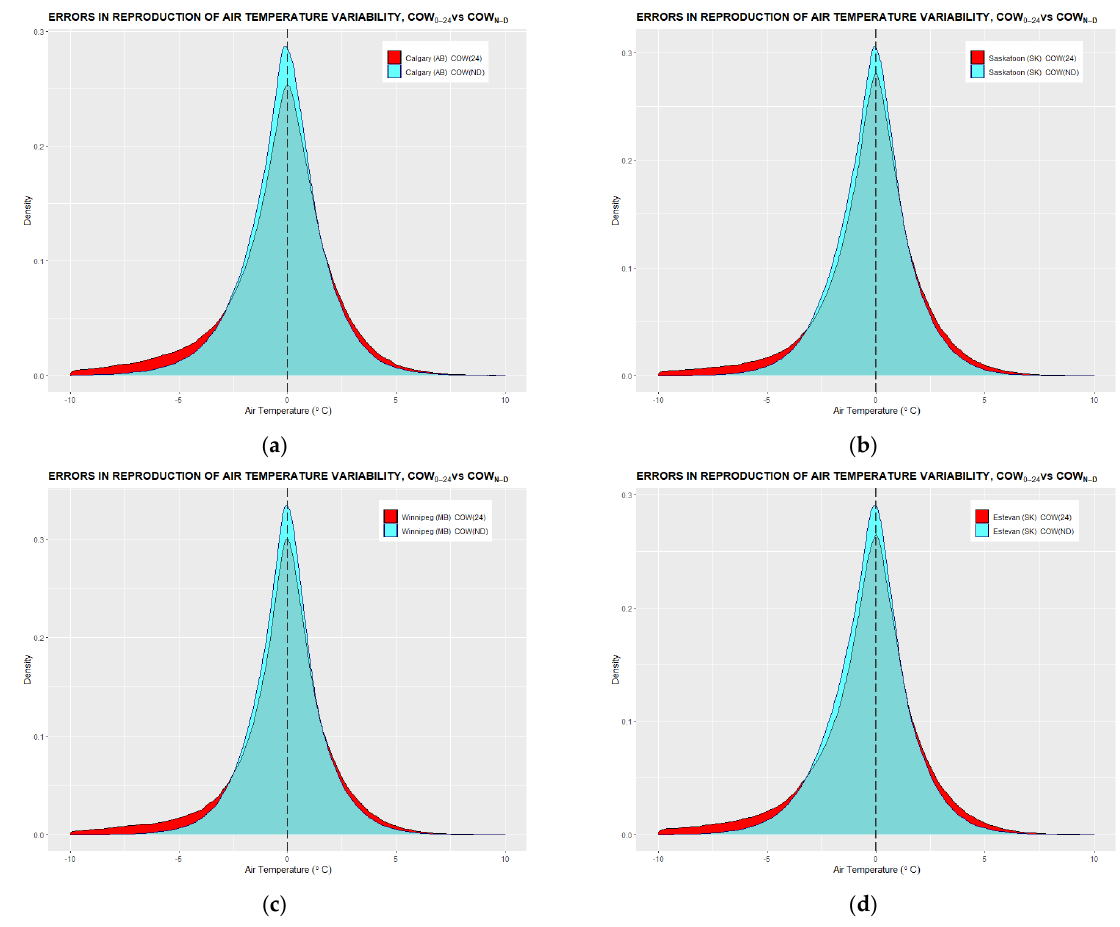
Figure A3. Prairies climate region. Histograms of conformity of COW 0–24 and COW N–D reproduced temperature with observed hourly temperature data for the 1953–2018 data period at Calgary ( a ), Saskatoon ( b ), Winnipeg ( c ), and Estevan ( d )